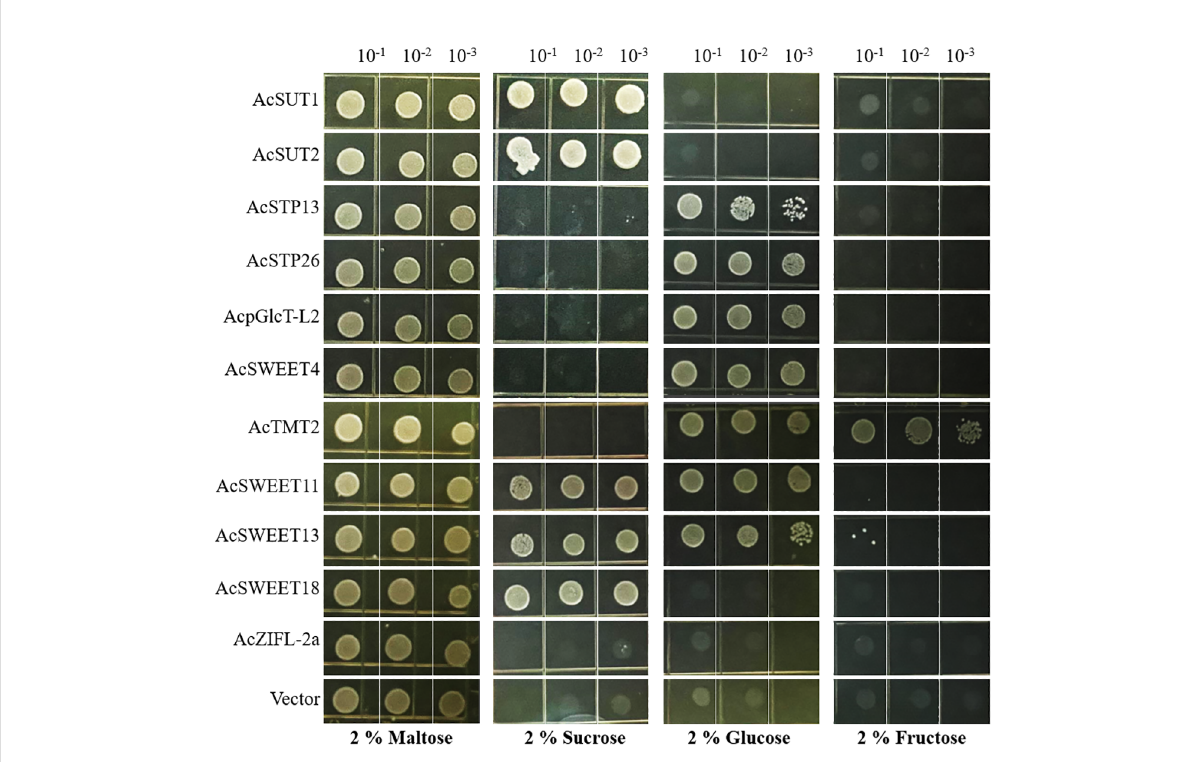
FIGURE 11 Heterologous expression of representative sugar transporters in the hexose transport-defective yeast strain EBY.VW4000. The yeast cultures harboring respective vectors were incubated until OD 600 reached 0.2 and then grown in serial dilutions on SD (-Trp) media containing either 2% maltose (positive control), 2% sucrose, 2% glucose or 2% fructose. The plates were incubated at 30°C, and the growth was documented after